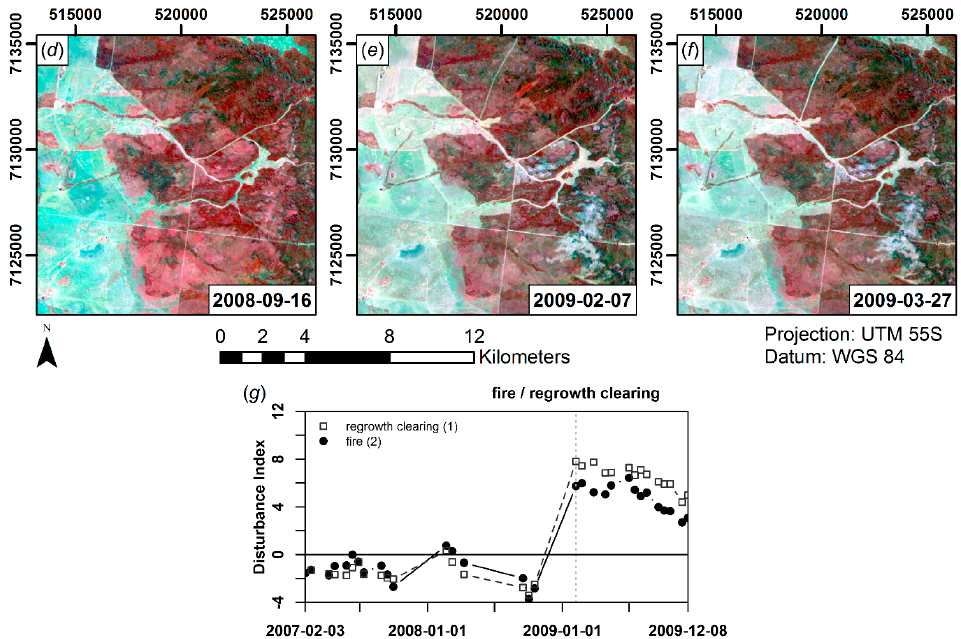
Figure 8. SLATS reference dataset, Landsat disturbance detection result for an area affected by regrowth, clearing and burning: ( a ) SLATS forest clearing (blue: 2008; yellow: 2009); ( b ) Landsat disturbance detection (see Figure A1 for the random color coding); ( c – f ) Landsat images depicting the clearing stages (RGB = NIR; SWIR1, red); and ( g ) temporal profiles of the Disturbance Index for two selected pixels marked in ( b ).